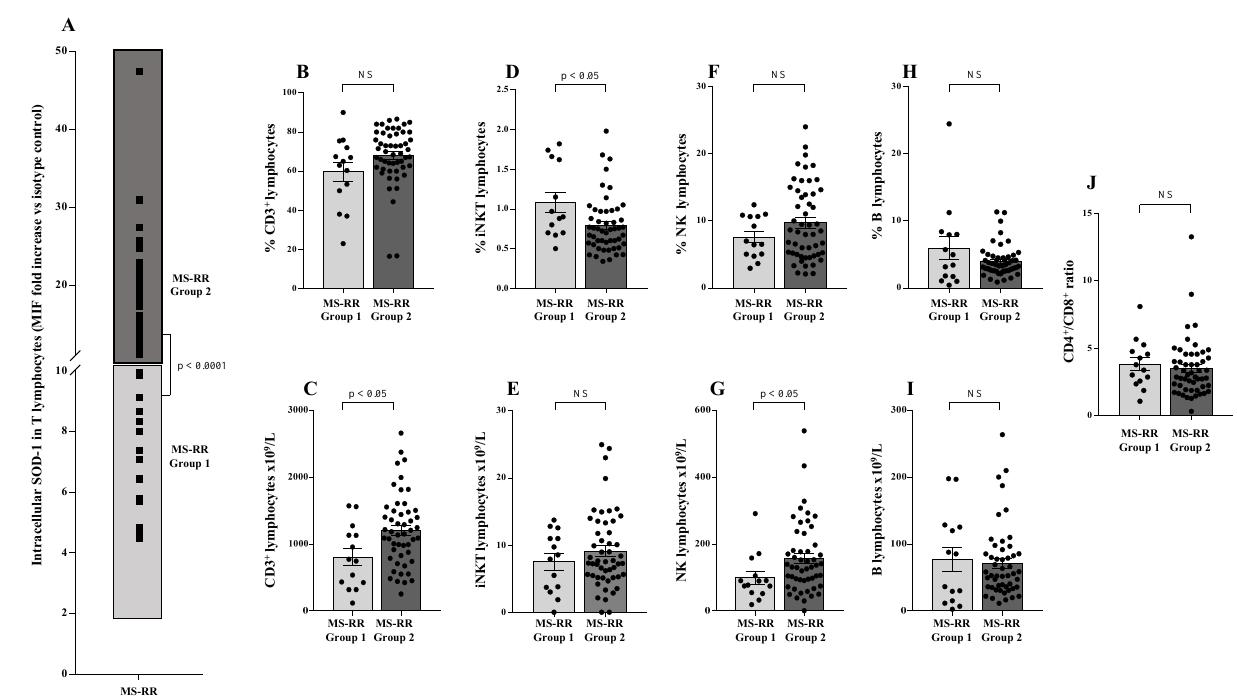
Figure 5. SOD-1 intracellular content in T cells identified two sub-groups of MS-RR individuals undergoing immune- modulating therapy, except fingolimod. ( A ) Analysis of SOD-1 distribution in T lymphocytes of MS-RR subjects undergoing all treatments, but fingolimod; as shown, Group 1 is MS-RR subjects characterized by SOD-1 intracellular content in T cells similar to healthy individuals (light grey box; SOD-1 MIF fold increase vs. isotype control <10); Group 2 is MS-RR subjects characterized by SOD-1 intracellular content in T cells significantly higher than healthy individuals (dark grey box; SOD-1 MIF fold increase vs. isotype control >10). ( B , D , F , H ) Percentage of circulating CD3 + , iNKT, NK, and B lymphocytes, respectively. ( C , E , G , I ) Numbers of CD3 + , iNKT, NK, and B lymphocytes, respectively. ( J ) CD4 + /CD8 + ratio. Statistical evaluation of data, was performed by means of the Mann–Whitney